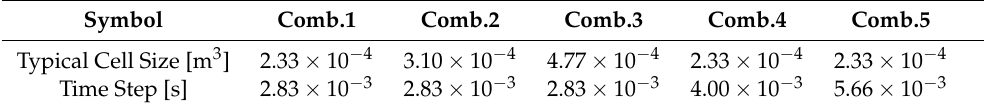
Table 5. Combinations of typical cell size and time steps used in the free decay test of pitch.